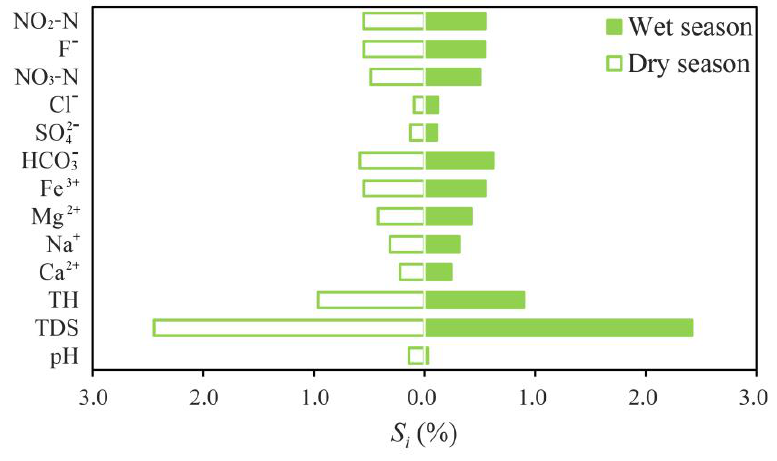
Figure 7. Sensitivity analysis of different water quality parameters based on IWQI